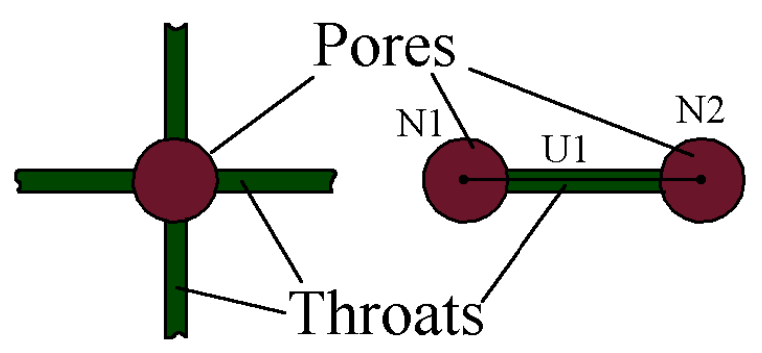
Figure 2. Network elements: pores and throats ; elements of the hydraulic network are superimposed in the right part of the schematic sketch.